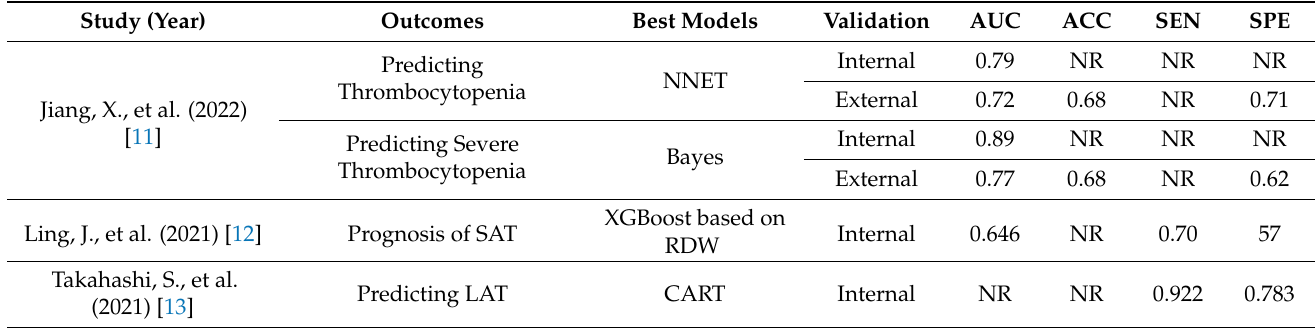
Table 2. Performance metrics for the best models in the included full-text